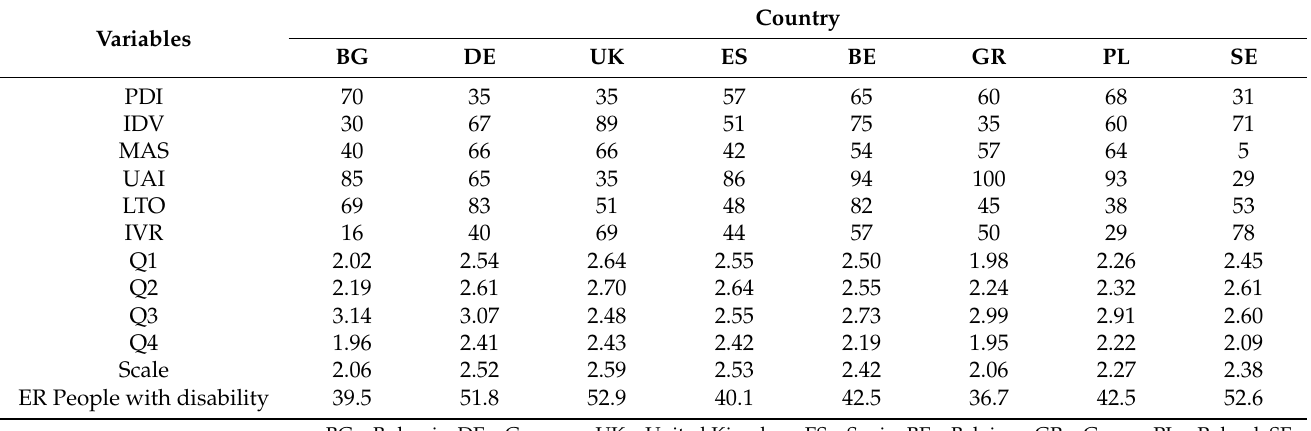
Table A1. Values of Hofstede’s indexes, average responses obtained from the proprietary question- naire and the employment rate of people with disability in specific